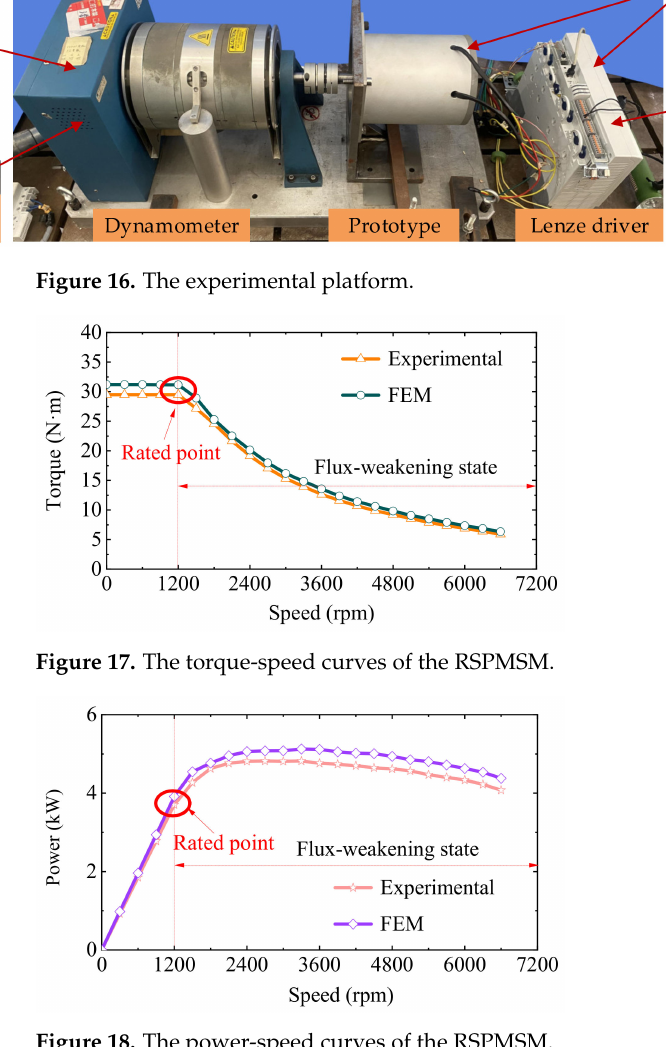
Figure 18. The power-speed curves of the